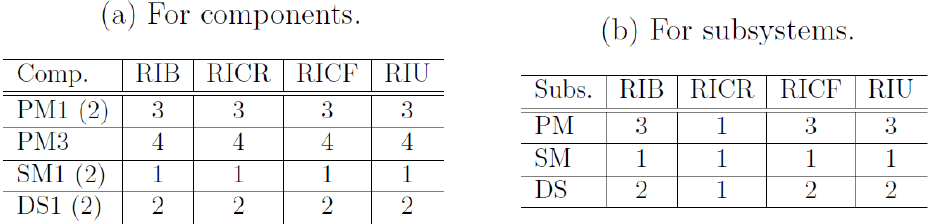
Table 14. Importance ranking of components and subsystems at time 𝑡 = 8000